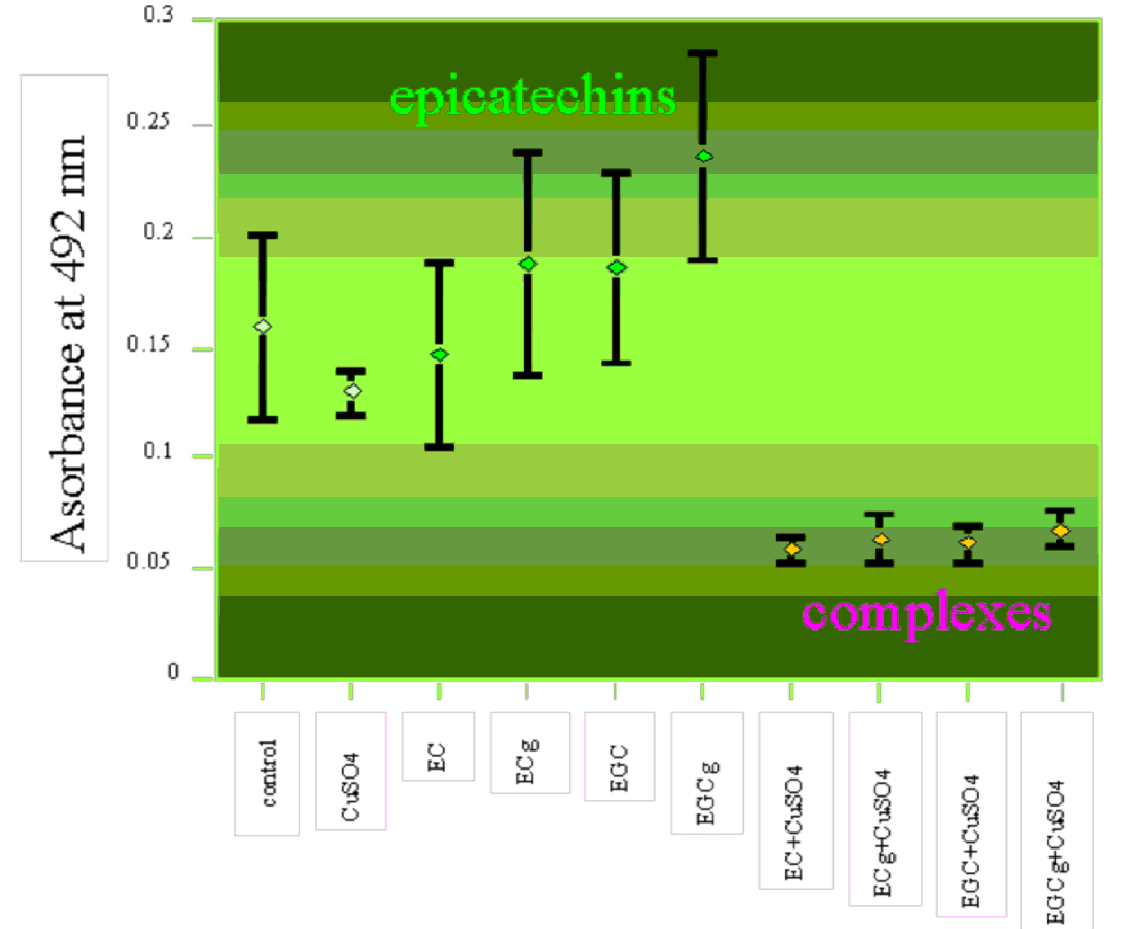
Fig. 4 Activity (viability) of Caco-2 cells, expressed as absorbance of MTT formazan at 492nm. Cells were incubated for 30 min with 1 mM EC, ECg, EGC, EGCg, and four epicatechin-copper complexes and copper sulfate respectively, compared with the control group (saline